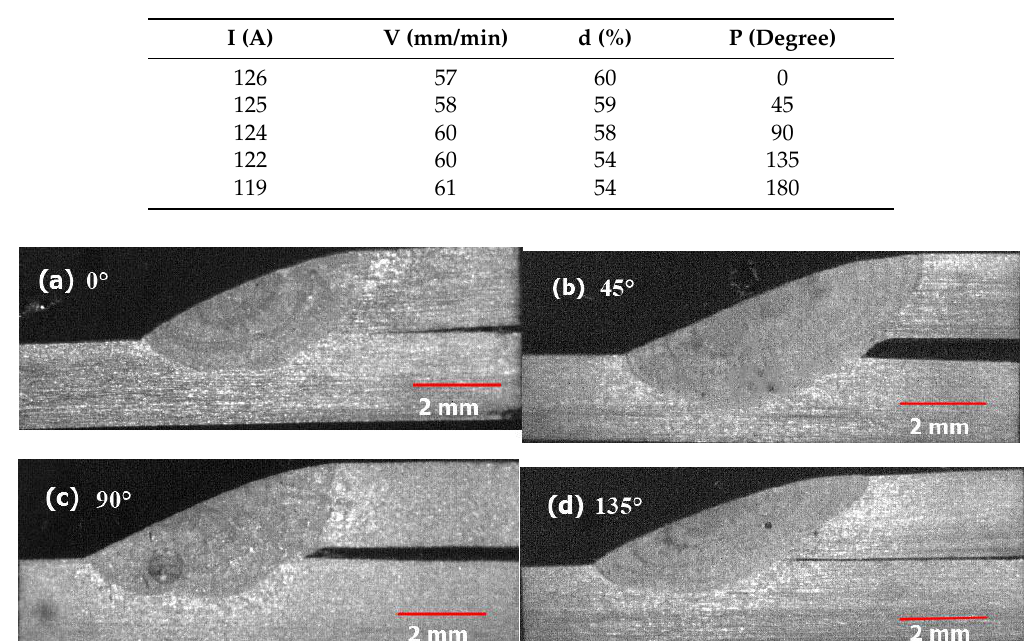
Figure 20. Cross sections of weld bead at different welding position from 0 – 180°. ( a ) 0° welding